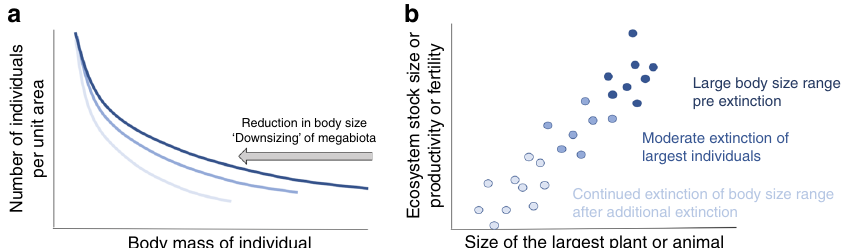
Fig. 2 Conceptual diagram for how the downsizing of the biosphere (the sequential loss of the megabiota) in fl uences the total amount of ecosystem stock (biomass, carbon, nutrients), productivity, or fertility. In ( a ), for assemblages of either plants or animals, there is an inverse relationship between size and abundance. But, as larger organisms are disproportionately more prone to population reduction and extinction than smaller organisms, this leads to a reduction in the number of larger body sized individuals and a reduction in their numbers. As a result, past extinction and continued hunting, fi shing, land and water use pressures in addition to climate change, are compressing body size distributions across most of the world ʼ s ecosystems. In ( b ) metabolic scaling theory and empirical data show that communities and ecosystems with larger body sized plants and animals fl ux more energy and resources. As a result, continued reductions in body size in ( a ) will lead to a continued reduction in ecosystem stocks and fl ux of energy and